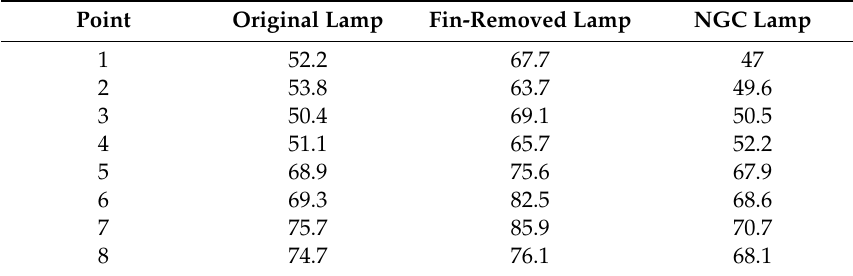
Table 7. Stable temperature distribution for the di ff erent LED lamps (Unit: ◦ C). Point